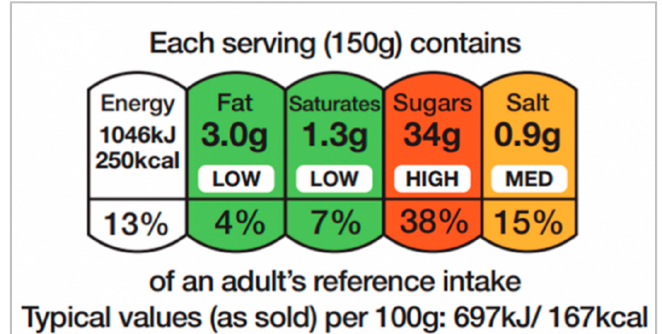
Figure A5. Multiple Traffic Lights (United Kingdom) was developed by the UK Food Standards Agency (FSA). It supplements traffic light colours (and optionally the adjectives “low”, “medium” and “high”) to the reference intakes for fat, saturated fat, sugars and salt. The colour green is assigned for low contents according to Regulation (EC) No 1924/2006. Red colour if the amount of nutrient per 100 g or 100 mL is more than 25% (12.5% for beverages) of the recommended maximum daily intake for an adult (If the portion size is more than 100 g or 150 mL, the thresholds apply per portion). Directiveness: Diet-Directive; Scope: All food; Gradation: three classes; Set of Reference: Across-Category; Sign: Colours, Numbers and Words.